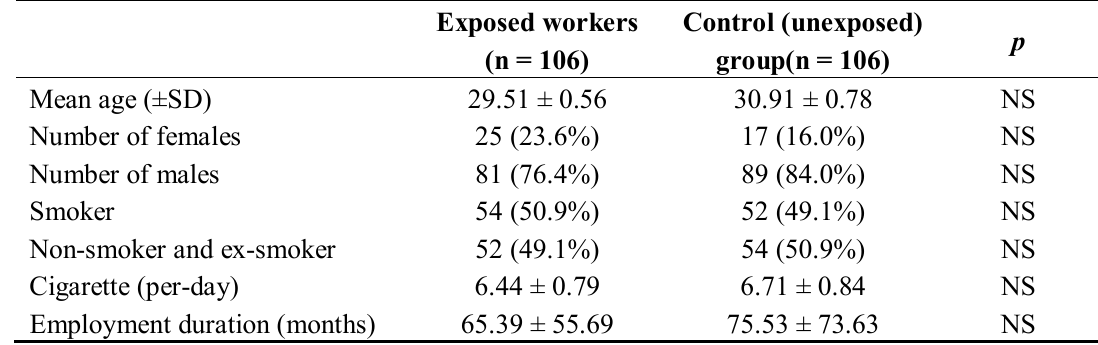
Table 1. The descriptive statistics (Mean ± SD, frequency and percentage) of the exposed workers and control (unexposed) group.